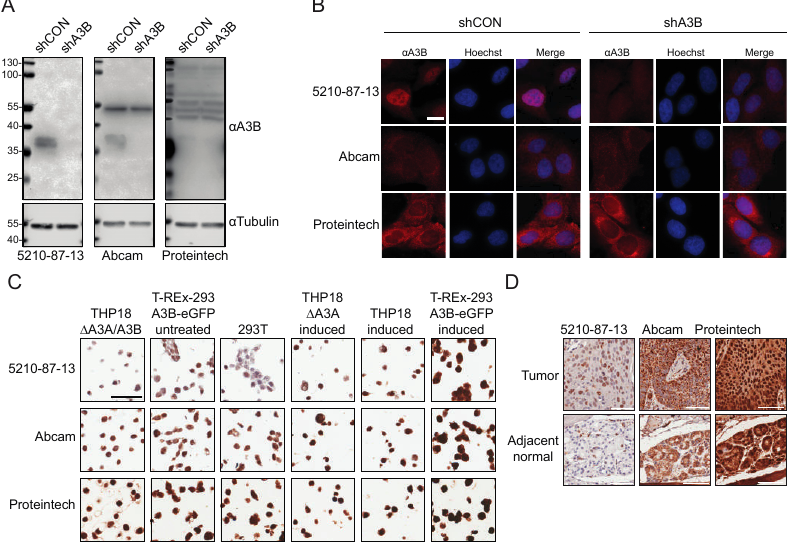
Figure 6. Comparison of 5210-87-13 and commercial rabbit mAbs advertised for A3B: ( A ) Immunoblots of whole cell lysates from U2OS cells expressing a control shRNA (shCON) or shA3B probed with the 5210-87-13, Abcam, or Proteintech mAb with anti-Tubulin as a loading control; ( B ) IF microscopy images of U2OS cells stained with the indicated rabbit mAb (scale bar is 10 µm); ( C ) IHC images of the indicated CMA cell lines stained with the 5210-87-13, Abcam, or Proteintech mAb (scale bar is 60 µm); and ( D ) IHC images of serial FFPE sections from the same tumor or adjacent normal tissue stained with the 5210-87-13, Abcam, or Proteintech mAb (scale bars are 60 µm). See text for details.